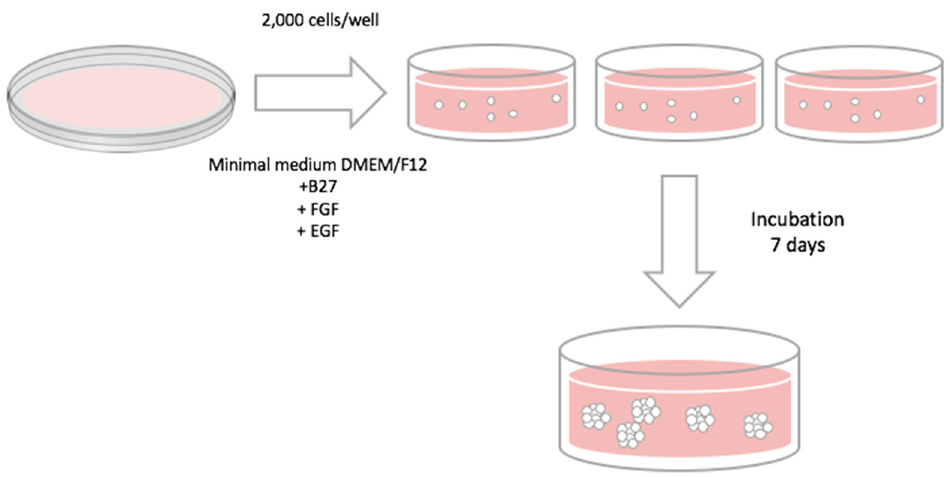
Figure 12. Mammosphere-forming assay protocol.